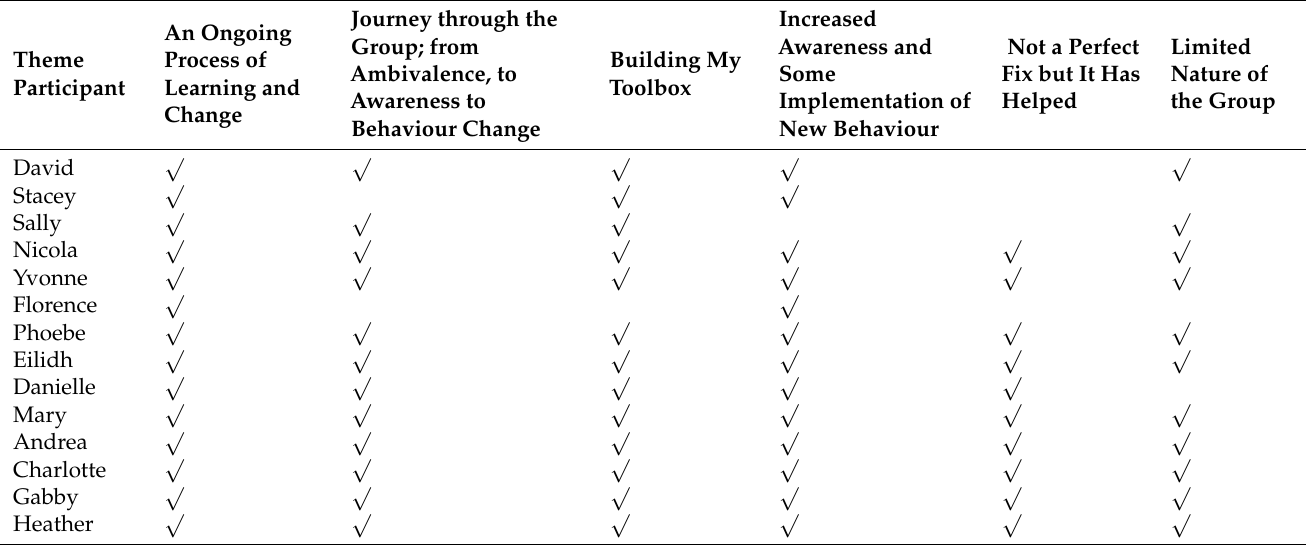
Table 3. Theme presence across participants.